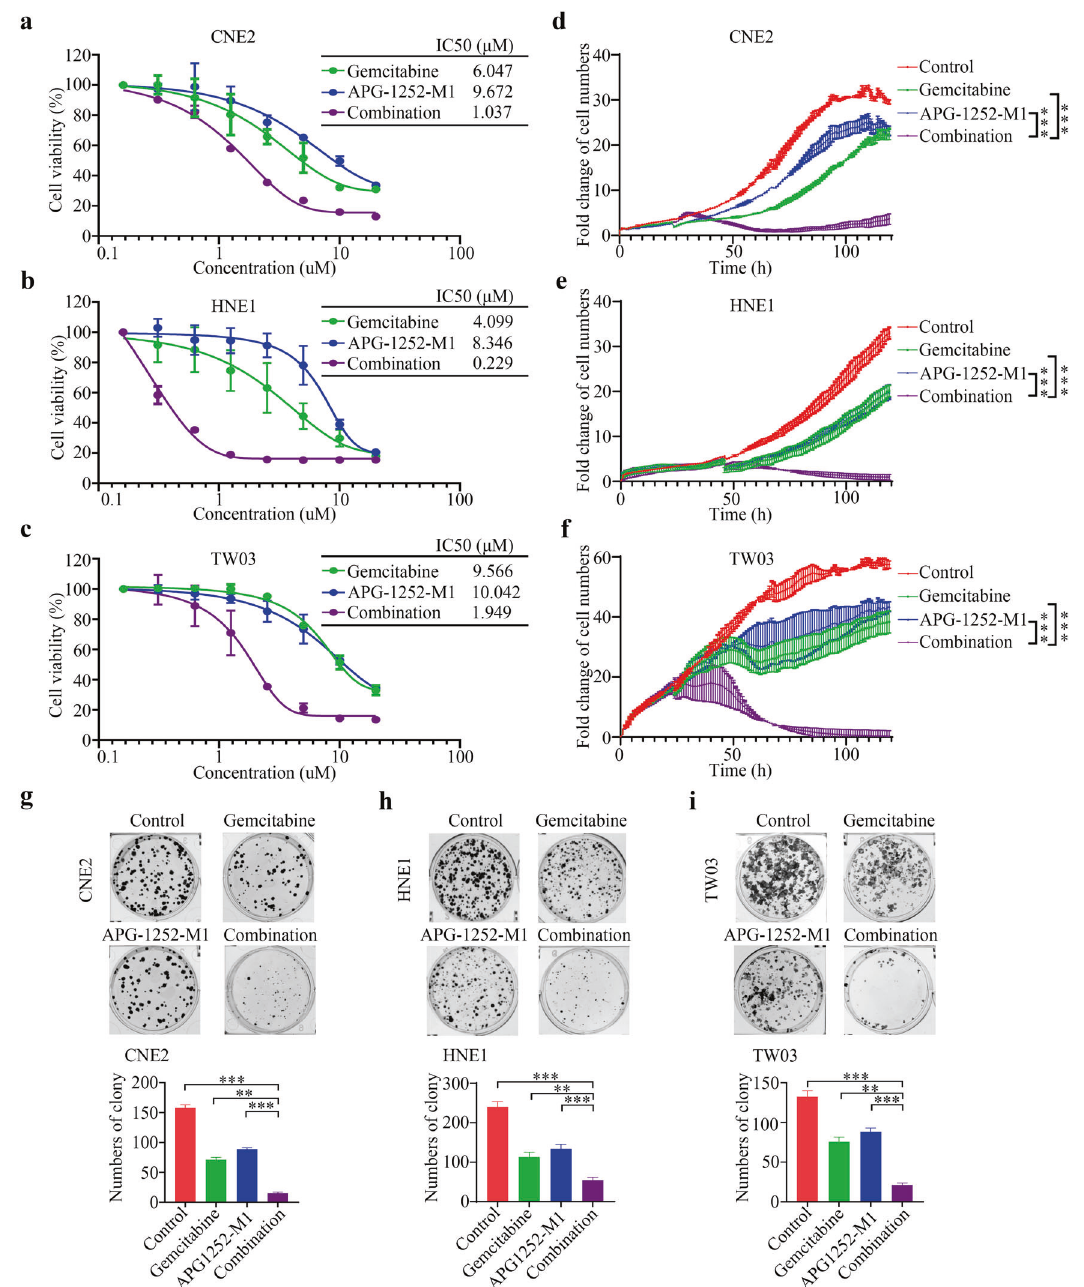
Fig. 1 APG-1252-M1 and gemcitabine inhibit the proliferation and oncogenic growth of NPC cells synergistically. a – c Various concentrations of gemcitabine, APG-1252, or their combination were used to treat CNE2, HNE1, and TW03 cells for 72 h. Cell proliferation was determined using a CCK-8 assay in triplicate. The IC50 values of gemcitabine, APG-1252, and their combination treatment in NPC cells were also analyzed. d – f Gemcitabine and APG-1252, alone or in combination, were used to treat CNE2, HNE1, and TW03 cells for different times. NPC cell proliferation was detected using RTCA. g – i The combination of gemcitabine and APG-1252 showed enhanced inhibition of NPC cell colony formation. Gemcitabine, APG-1252 or their combination were used to treat CNE2, HNE1, and TW03 cells at the indicated concentrations for approximately 14 days. The number of colonies stained by crystal violet was used to determine the anti-proliferative effects. The results shown are representative of three independent experiments. All data are presented as the mean±SD. * P < 0.05, ** P < 0.01, *** P < 0.001. NPC, nasopharyngeal carcinoma; CCK-8, Cell Counting Kit-8; RTCA, real-time cell